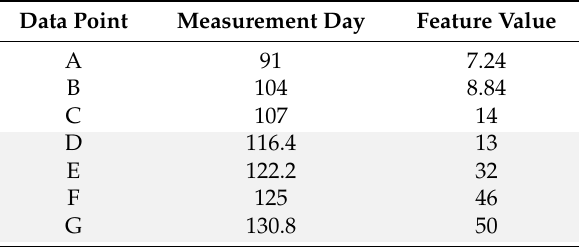
Table 11. Original non-linear data points and predicted data points of LLE feature.